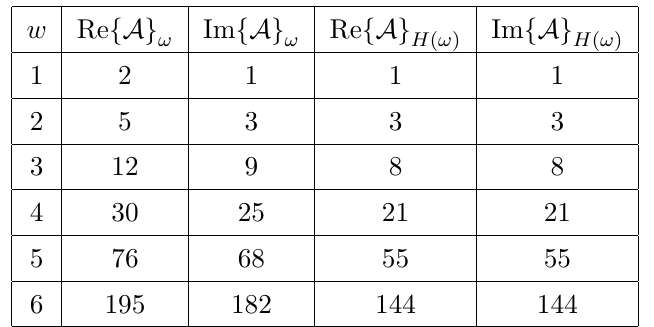
, Im fAg , Re fAg , and Im fAg ! ! H ( ! )